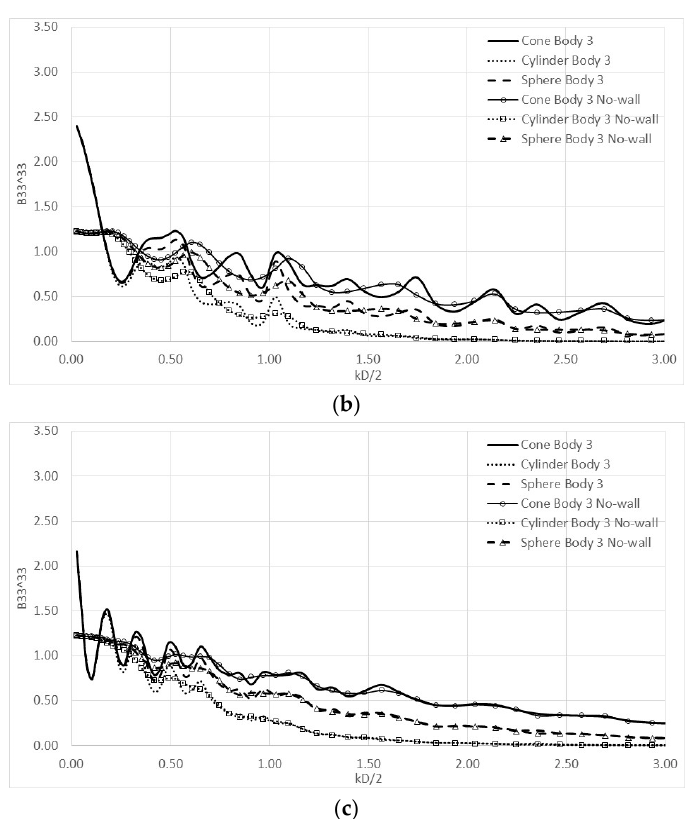
Figure 18. Dimensionless damping coefficient of the 3rd floater at the heave direction due to its motion at heave against kD/2, for the three different examined array configurations. Comparison with the corresponding damping coefficient of the same floater of the arrays without the presence of the breakwater: ( a ) parallel arrangement, C 1 ; ( b ) rectangular arrangement, C 2 ; ( c ) perpendicular arrangement, C 3 .